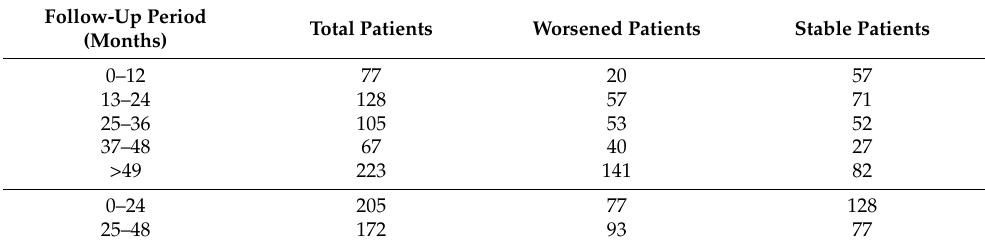
Table 2. Evolution of the patients’ carotid stenosis across the follow-up period.